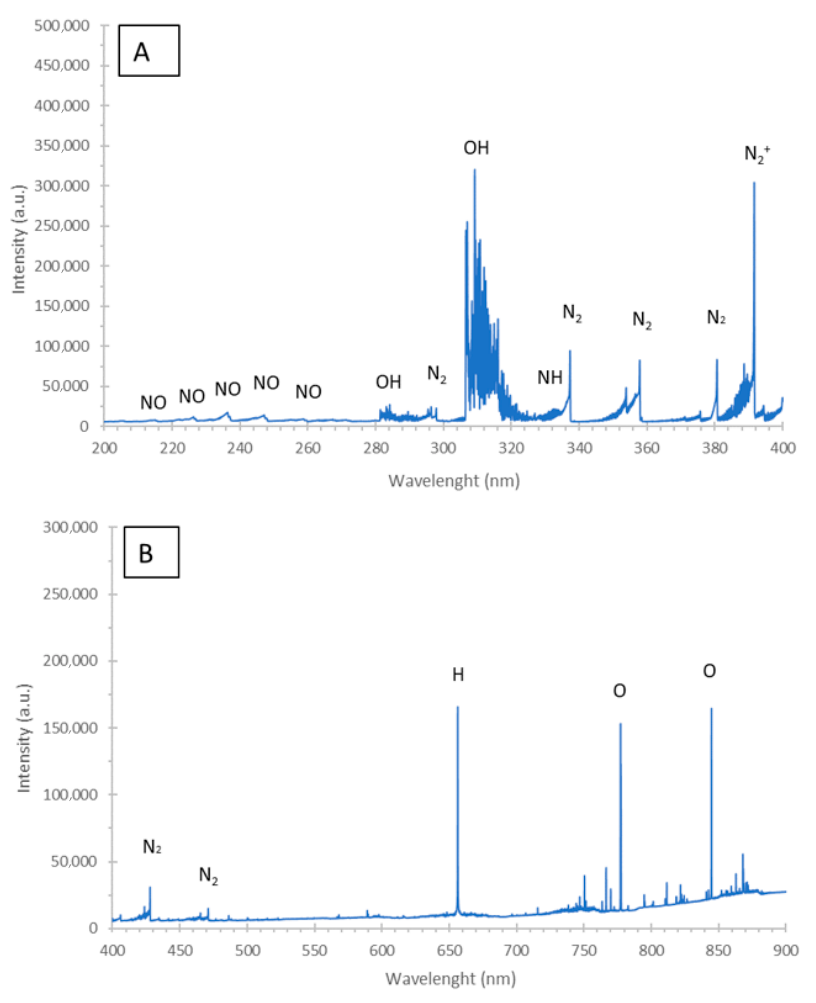
Figure 3. The optical emission spectra acquired in two spectral ranges: ( A ) 200–400 nm and ( B ) 400–900 nm during the FLC-dc-APGD treatment of the 0.5% NH 4 NO 3 solution under the optimal operating conditions.